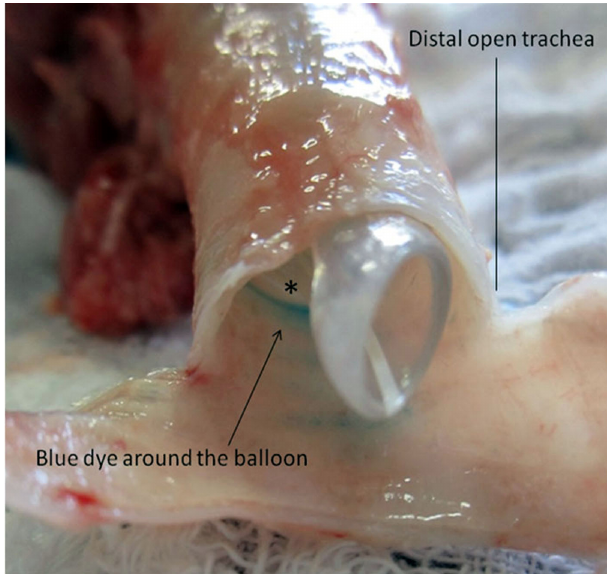
Fig. 2 - Porcine trachea isolated with a tracheal tube with cuff (*) inflated at 30cmH O pressure. The blue dye was introduced in the 2 (proximal) upper region of the inflated cuff. After four minutes, the dye had leaked around the cuff